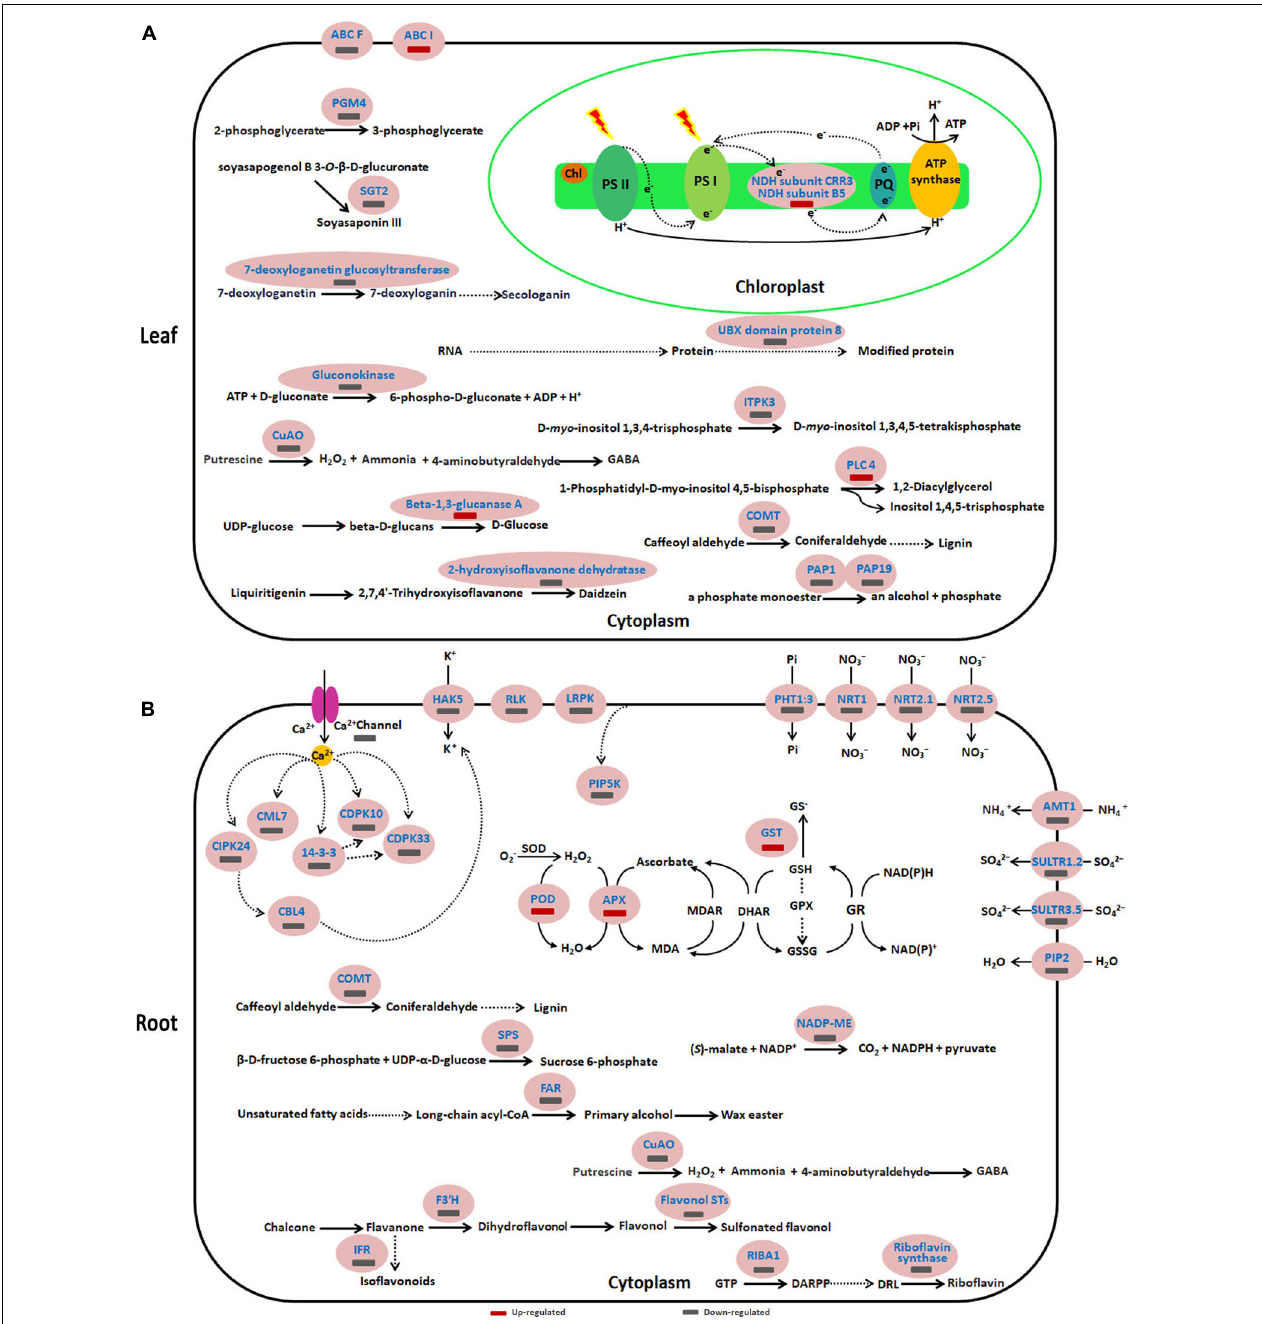
FIGURE 6 | Schematic presentation of key differentially expressed proteins (DEPs) involved in the response of sugar beet to acid stress. (A,B) represent the differentially expressed proteins in leaves and roots, respectively. Blue highlighted proteins indicate only increased or decreased in the group of pH 5 vs. pH 9.5. AMT1, Ammonium transporter 1; CBL, Calcineurin B-like protein; CDPK, Calcium-dependent protein kinase; CIPK, CBL-interacting serine/threonine-protein kinase; CML7, Calmodulin-7-like; COMT, caffeic acid 3-O-methyltransferase; CuAO, copper-containing amine oxidases; FAR6, Fatty acyl-CoA reductase 6; FST, Flavonol sulfotransferase; HAK5, High-affinity potassium transporter 5; IFR, isoflavone reductase-like; ITPK3, Inositol-tetrakisphosphate 1-kinase 3; NADP-ME2, NADP-dependent malic enzyme 2; NRT, Nitrate transporter; PAP, purple acid phosphatase; PGM4, phosphoglycerate mutase-like protein 4; PHT1:3, inorganic phosphate transporter 1-3; PIP2-1, Aquaporin PIP2-1; SGT, Soyasapogenol B glucuronide galactosyltransferase; SPS, Sucrose-phosphate synthase; SULTR, Sulfate transporter.